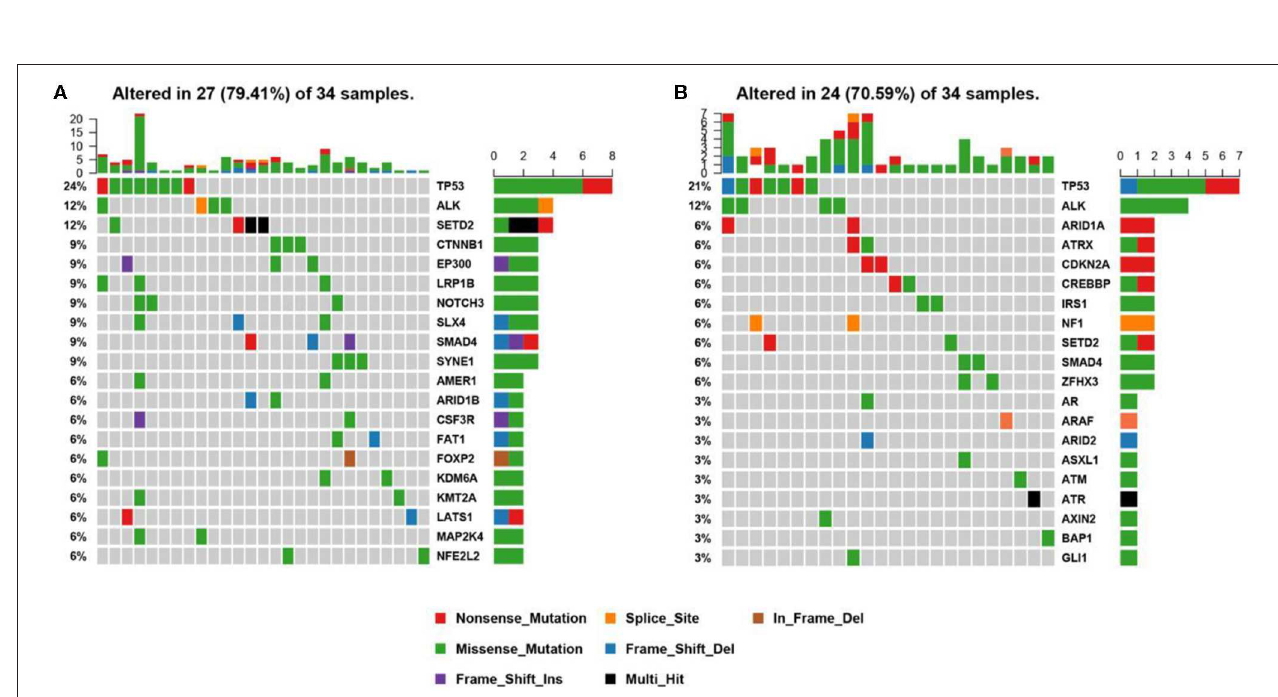
FIGURE 3 | Mutational profiles of ALK positive NSCLC patients. (A) This is the oncoprint of the somatic SNVs and Indels in 34 patients in our study. Somatic alterations included missense, nonsense, frameshift indel, in-frame indel, splice site, translation start site, multi_Hit mutations. The genes are ranked by the frequency of the mutations across all samples. (B) This is the oncoprint of the somatic SNVs and Indels in 34 patients from the MSK-IMPACT study. Somatic alterations included missense, nonsense, frameshift indel, in-frame indel, and splice-site mutations. The genes are ranked by the frequency of the mutations across all samples.